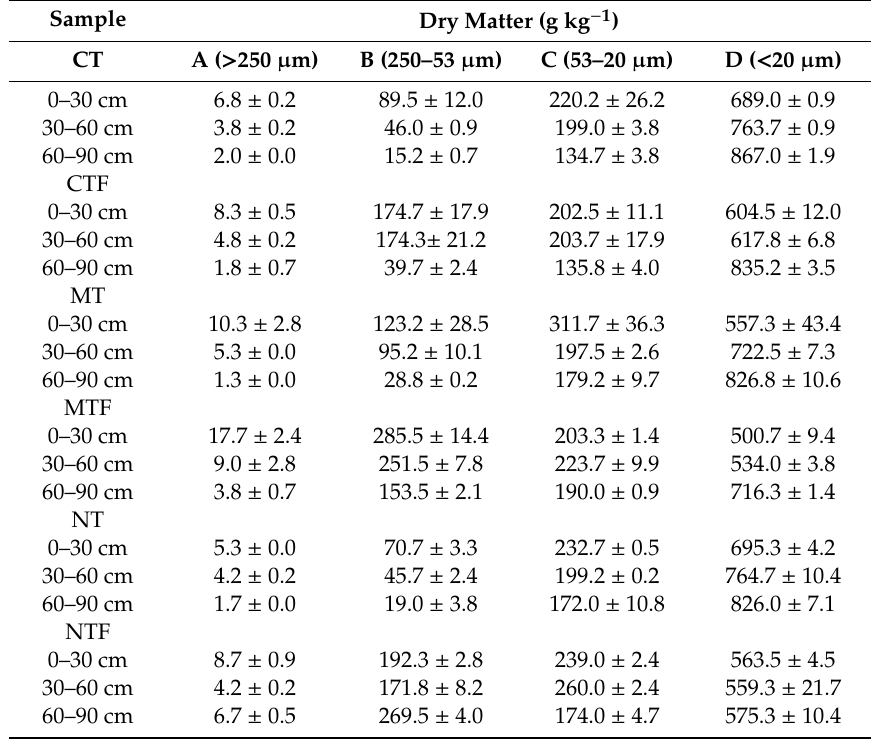
Table 1. Amount of soil dry matter in the size fractions (g kg − 1 soil) (mean ± standard deviation).